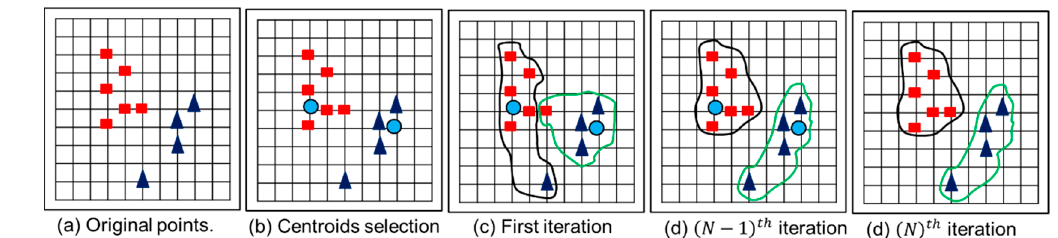
Figure 14. The formulation of different coloring options used in k -mean clustering algorithm.